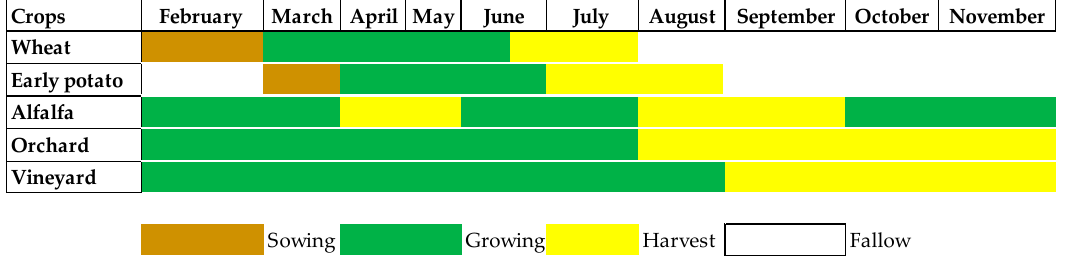
Figure 7. Crop calendars for the Bekaa Valley culture (spring and permanent crops in 2017).